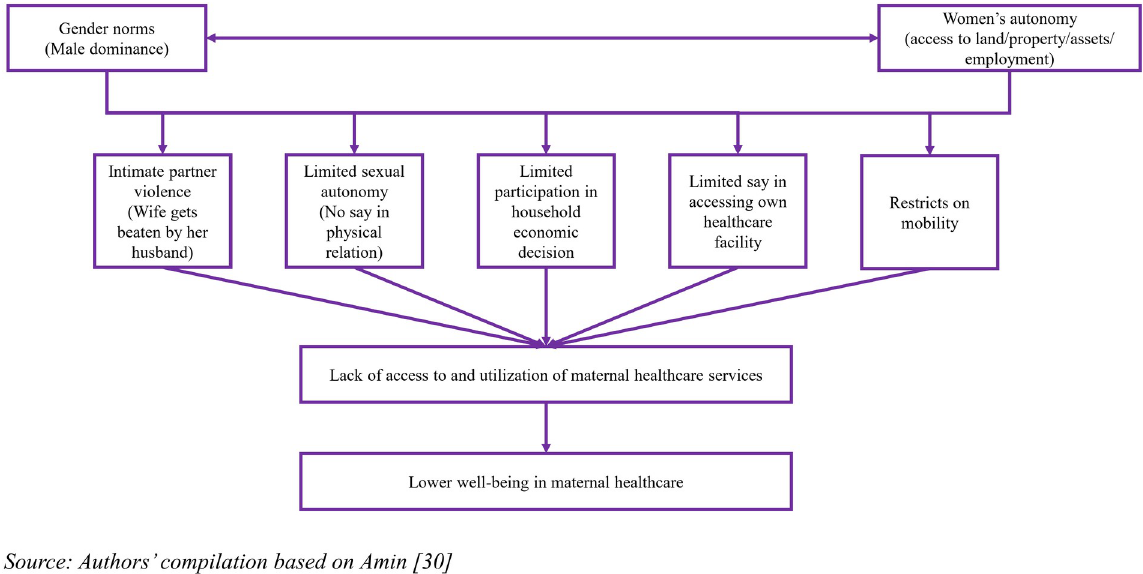
Fig 1. Pathways explaining how gender inequality shapes maternal healthcare